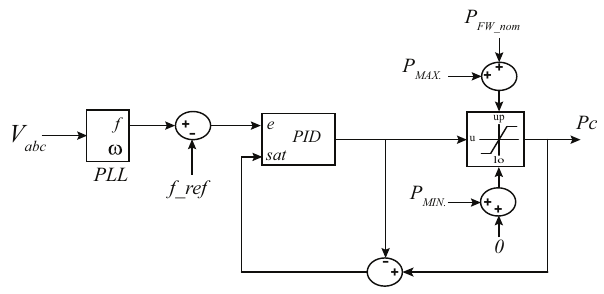
Figure 8. PI regulator for frequency